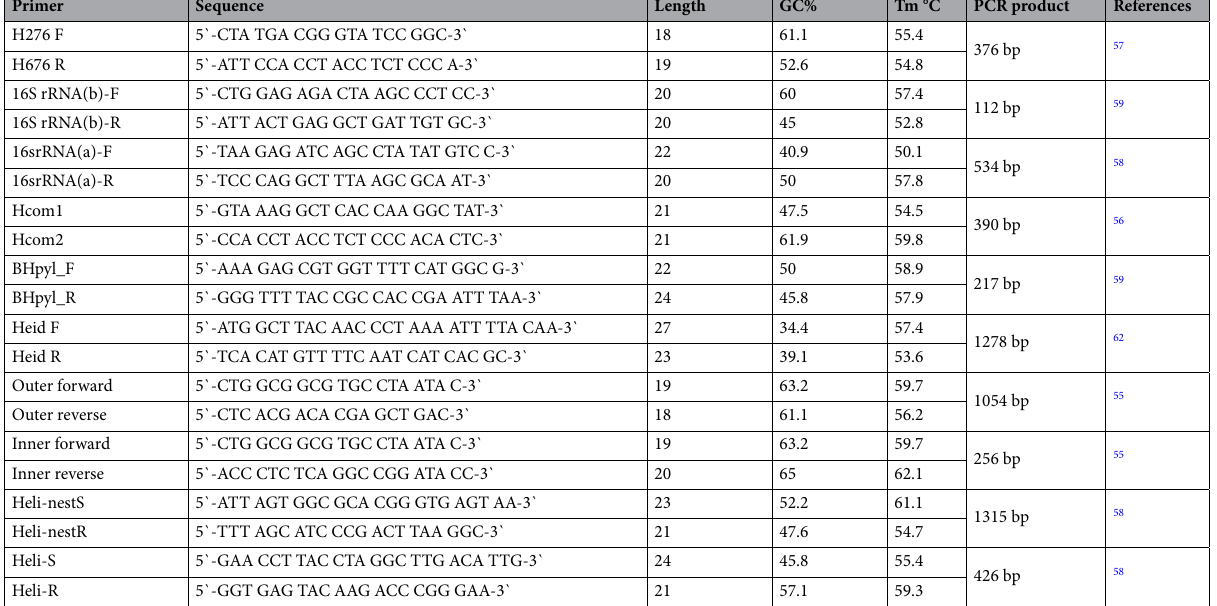
Table 5. The sequence of different primers for detection of G: